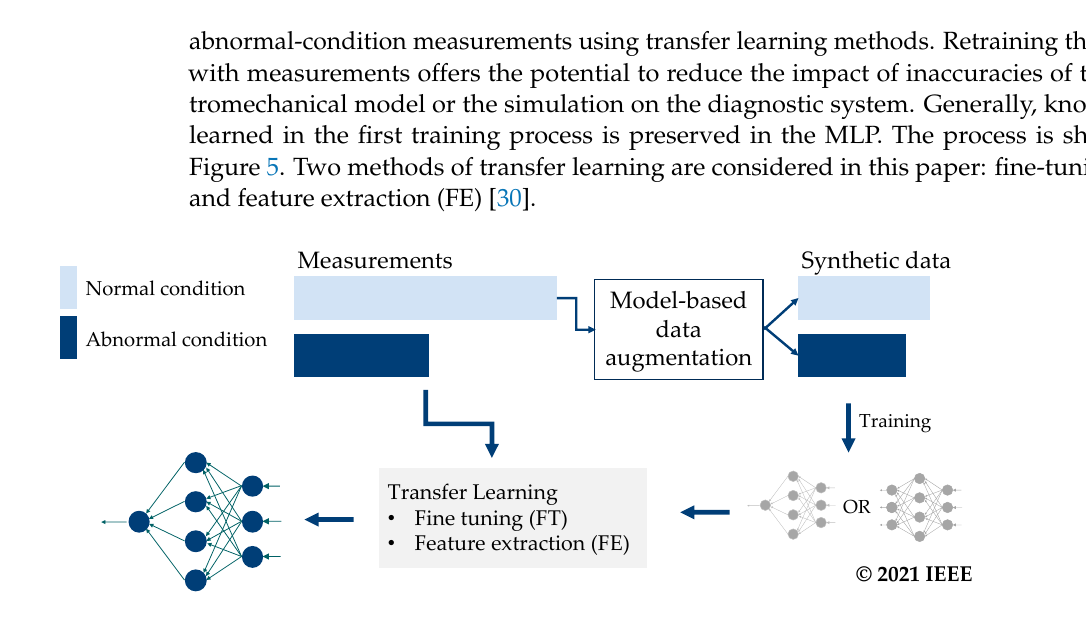
Figure 5. Training of MLPs with synthetic data and transferring MLPs to measurements using transfer learning [30].